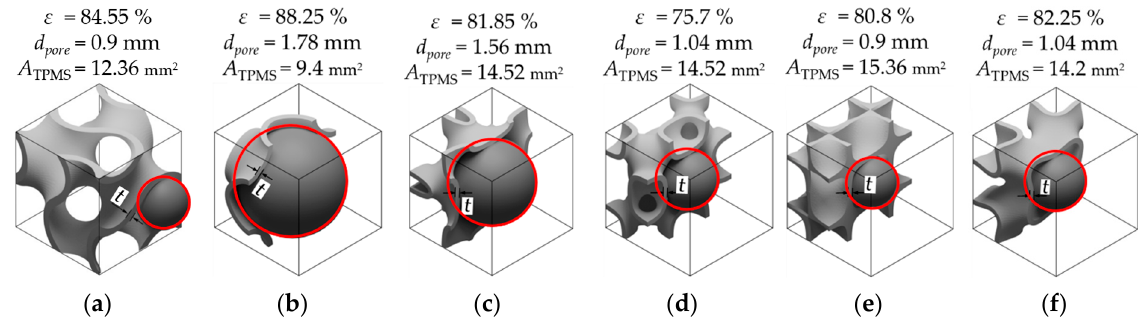
Figure 13 . Variations in porosity, pore size, and surface of TPMS at c = 0 at the wall thickness of t = 0.1 mm and unit cell size of L = 2.0 mm for a unit cell of sheet-based TPMS structures (The correlations for the porosity, pore size and surface area are provided by Poltue et al. [32]): ( a ) Sheet-Gyroid; ( b ) Sheet-Primitive; ( c ) Sheet-Neovius; ( d ) Sheet-FRD; ( e ) Sheet-Diamond; ( f ) Sheet-IWP structures.